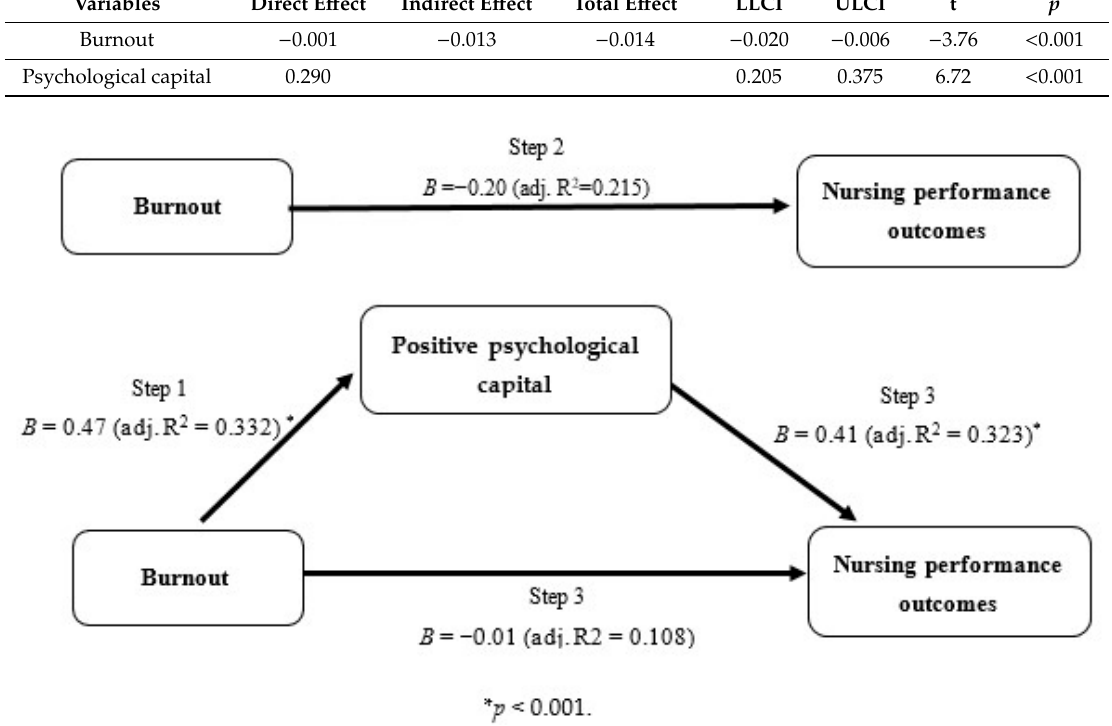
Figure 1. Mediating effect of positive psychological capital on the relationship between burnout and nursing performance outcomes.